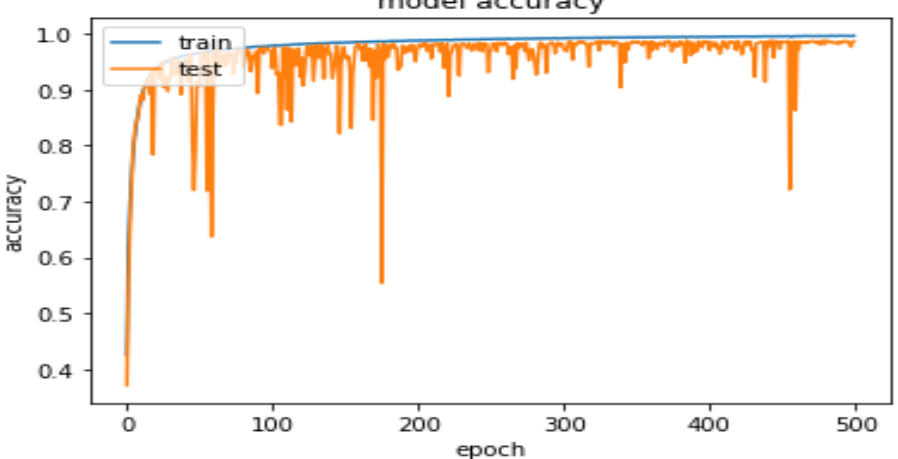
Figure 7. Model accuracy in training and testing